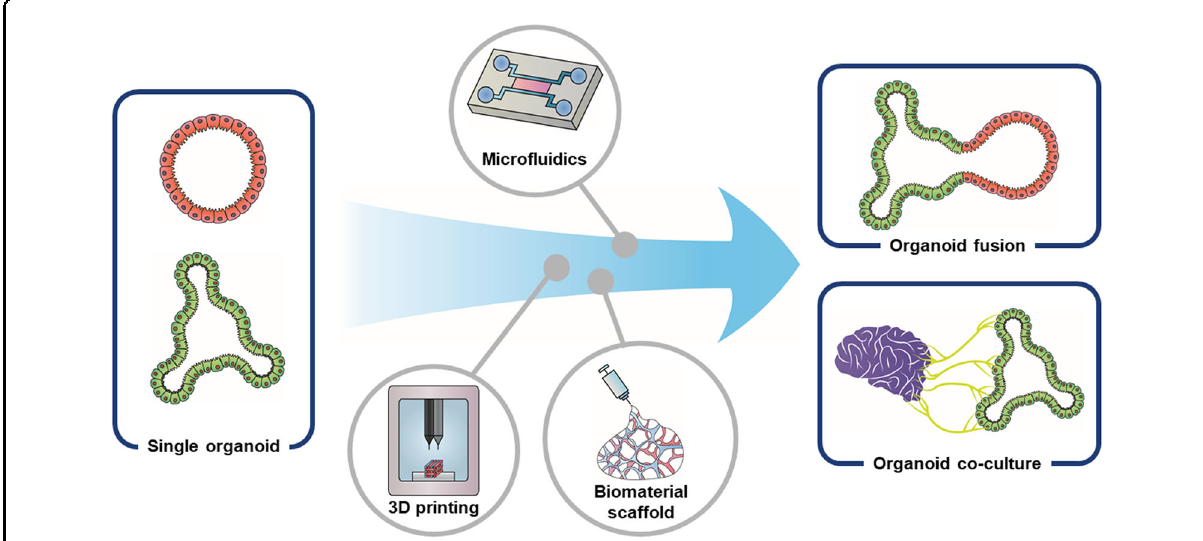
Fig. 3 Bioengineered platforms for developing GI organoids assembled with other types of organoids. Through bioengineering techniques such as 3D bioprinting and the use of micro fl uidics and biomaterials, a novel integrated GI system can be developed by connecting the various organoids that make up the digestive system or by coculturing with completely different types of organoids such as brain organoids. These innovative organoid systems enable the modeling of highly complex human physiology, such as reciprocal regulation between the GI tract and other major organs, and pathological phenomena associated with